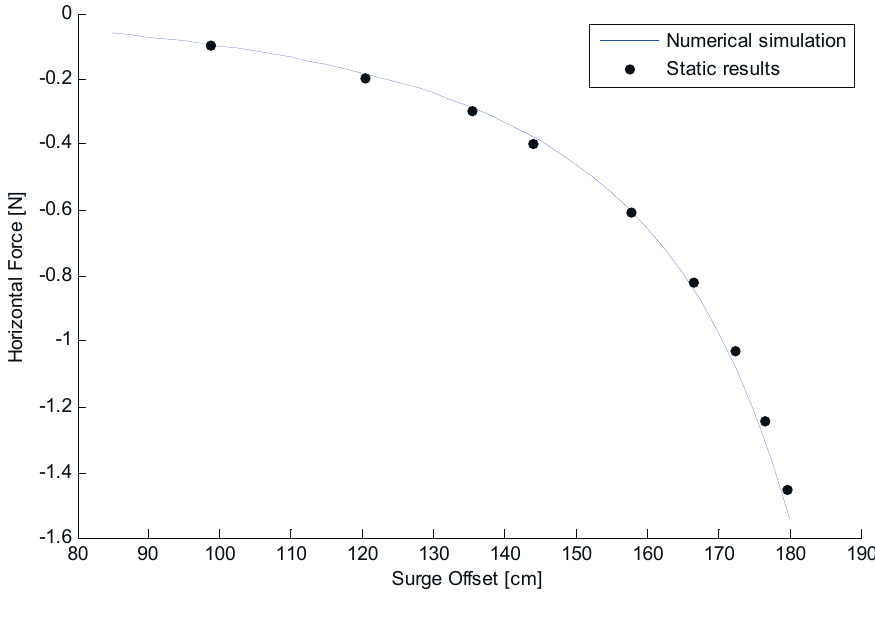
Figure 13. Comparative horizontal force